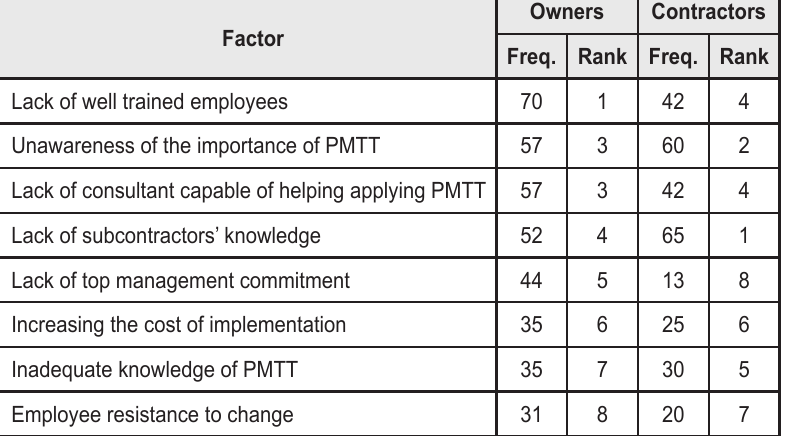
Table 5: Ranking of obstacles to non-efficient utilisation of PMTT